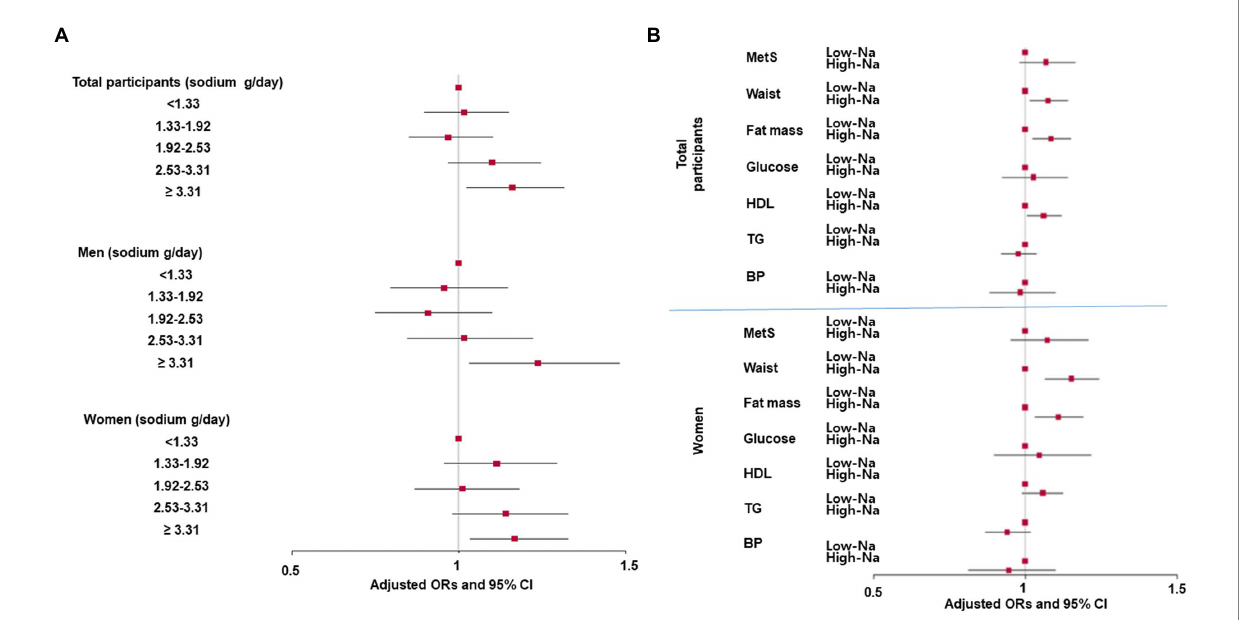
FIGURE 1 Association of sodium intake with metabolic syndrome (MetS) and its components according to gender. (A) Adjusted odds ratio and 95% confidence intervals of MetS with sodium intake by quintiles and (B) Adjusted odds ratio and 95% confidence intervals of MetS and its components with low-and high-sodium intake. (Cutoff: 1.5 g sodium intake/day) The cutoff point of each MetS component for logistic regression were as follows: MetS criteria based on the 2005 NCEP-ATP III criteria for Asians; <90 cm for men and 85 cm for women waist circumferences; <25% for men and 30% for women for fat mass; <110 mg/dL fasting serum glucose plus diabetic drug intake; <40 mg/dL for men and 50 mg/dL for women serum HDL cholesterol; <140 mmHg systolic blood pressure (SBP) or diastolic blood pressure (DBP) <90 mmHg plus hypertension